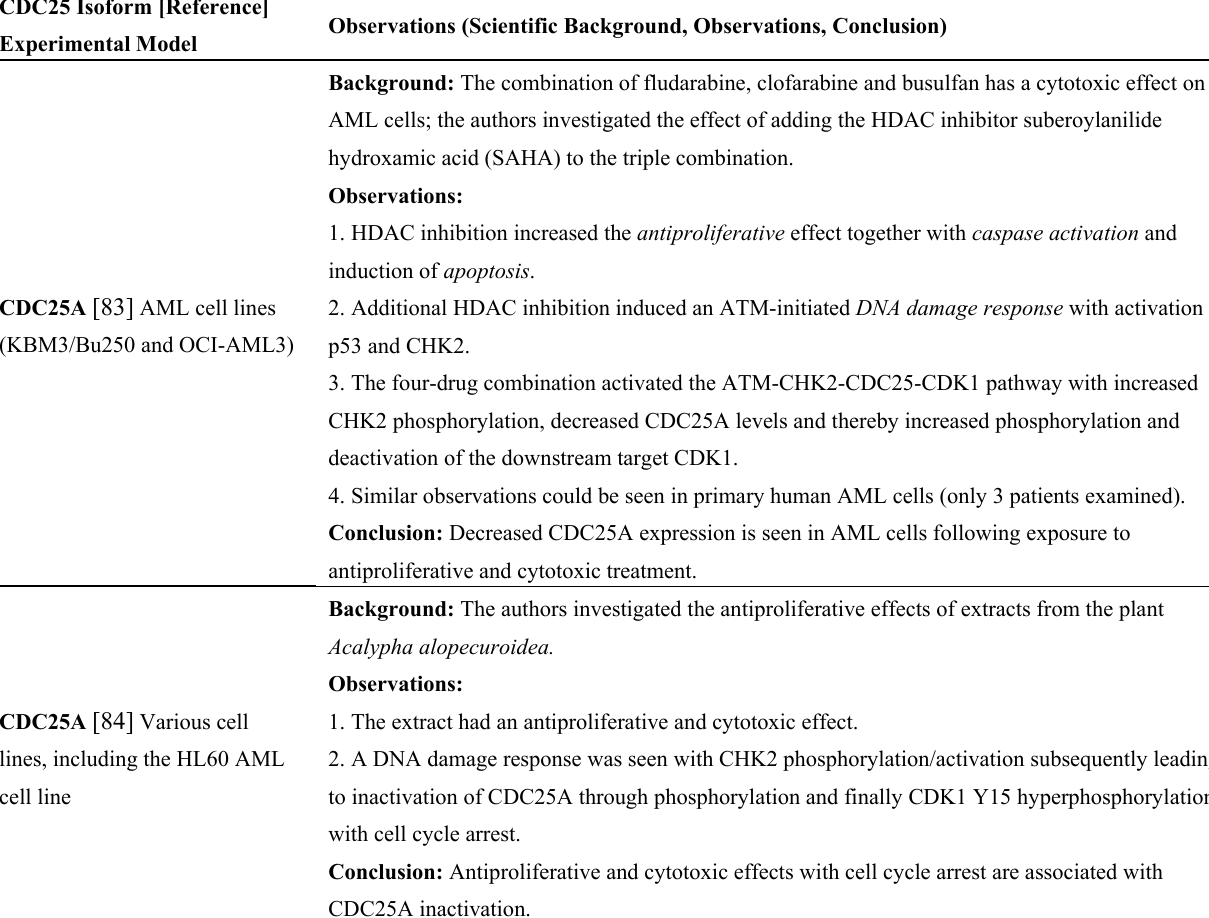
Table 1. The importance of CDC25 in AML; a summary of previous